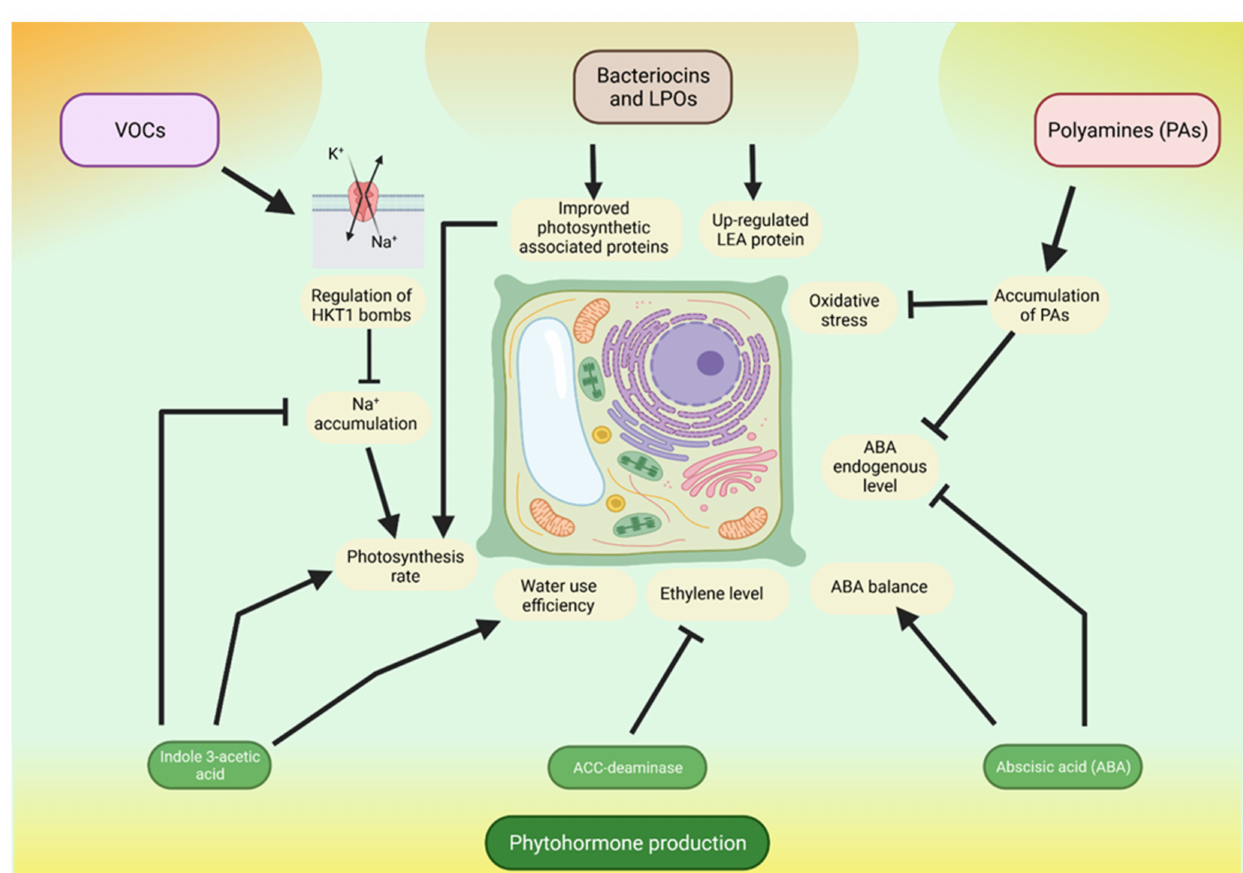
Figure 2. Molecules synthesized by PGPB involved in plant salinity